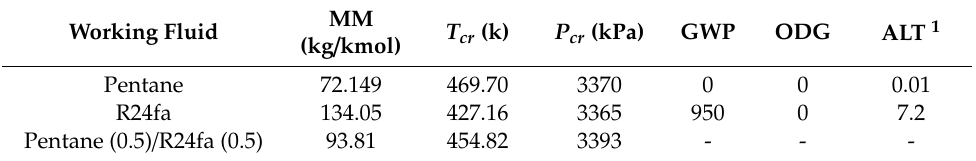
Table 1. The characteristics of the pure working fluids and their combination.